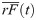
Photobleaching of BcO binding to AV at 15°C.The photobleaching rate constant was elucidated with the (A)
rF¯(t) and (B)
F¯(t) signals by collecting the reaction with continuous (black) and discontinuous (dashed color) laser illumination in which the beam was blocked during the times denoted by dashes and the sample was illuminated only during time intervals of 10 s. The slow photobleaching rate constant varied from 6 × 10−3 to 1 × 10−2 s-1, and was laser power dependent. The (A) rF¯(t) and (B) F¯(t) normalization functions were: rF¯(t)=[rF(0)−rF(t)]/[rF(0)−rF(∞)] and F¯(t)=F(t)F(0)=[F(t)−rF(∞)]/[rF(0)−rF(∞)], respectively.